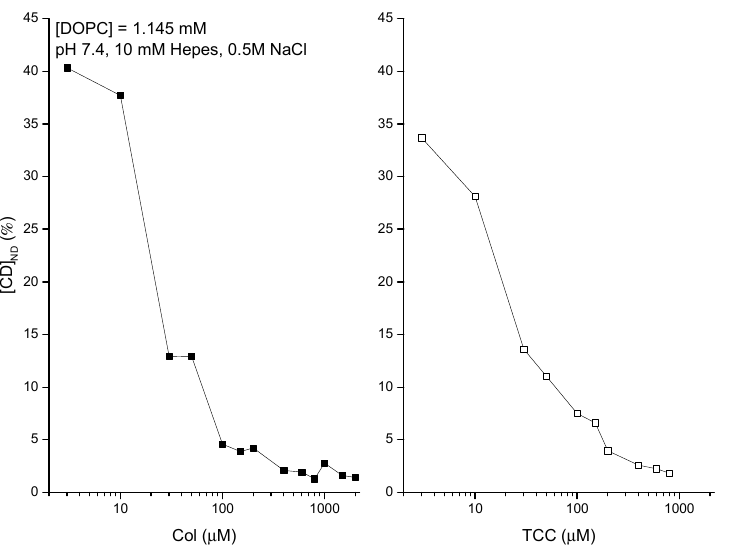
Figure 7. Percentage (%) of liposome-adsorbed CDs of their respective concentrations in buffer. These plots are deducted using the mean values presented in Figure 6.